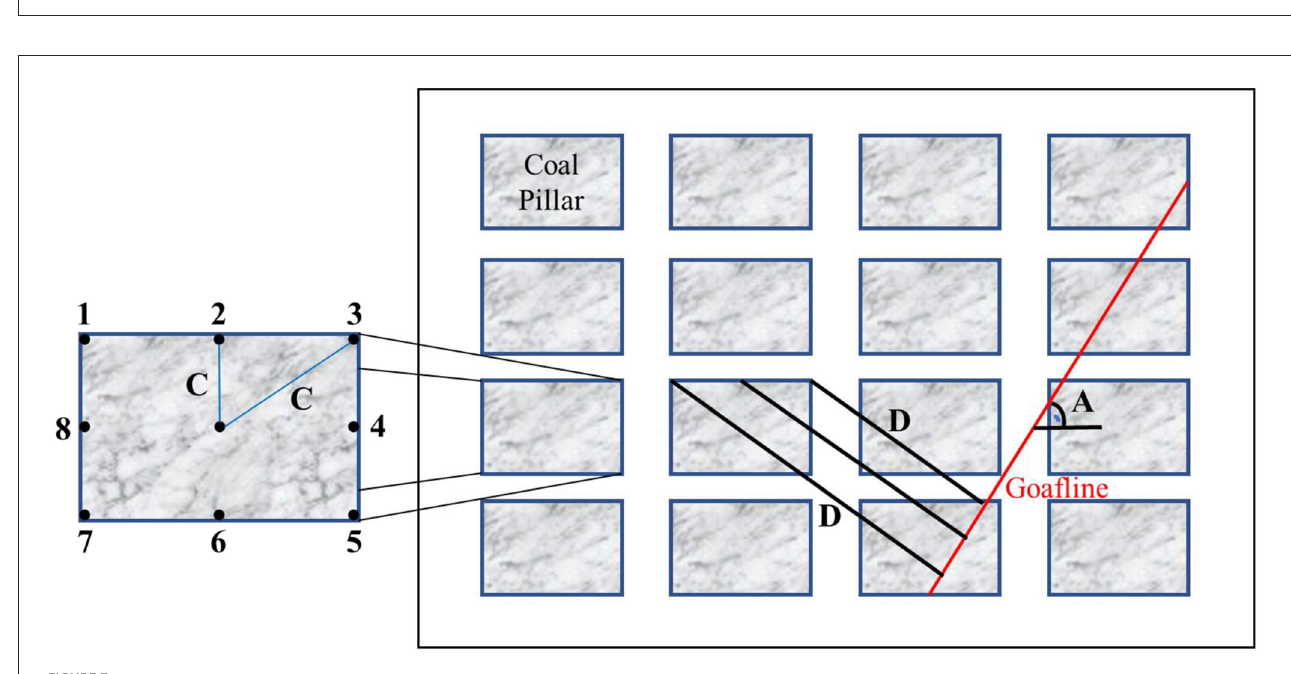
FIGURE3 Plan of a sub-panel